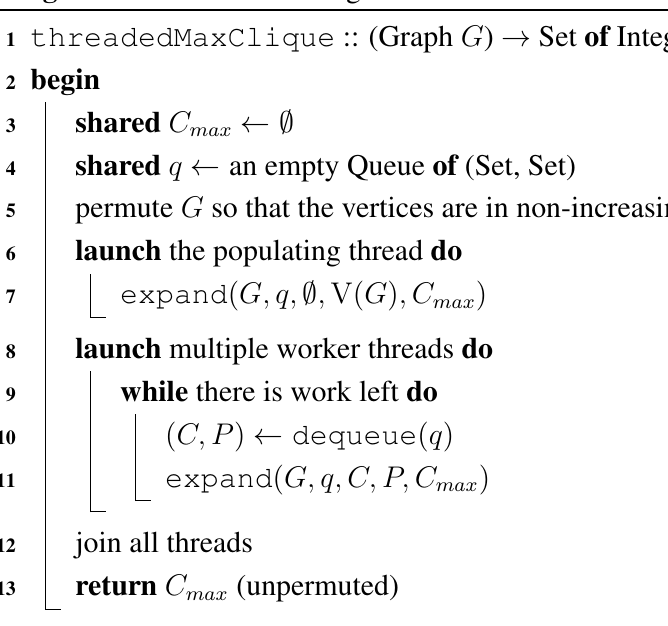
Algorithm 3: A threaded algorithm to deliver a maximum